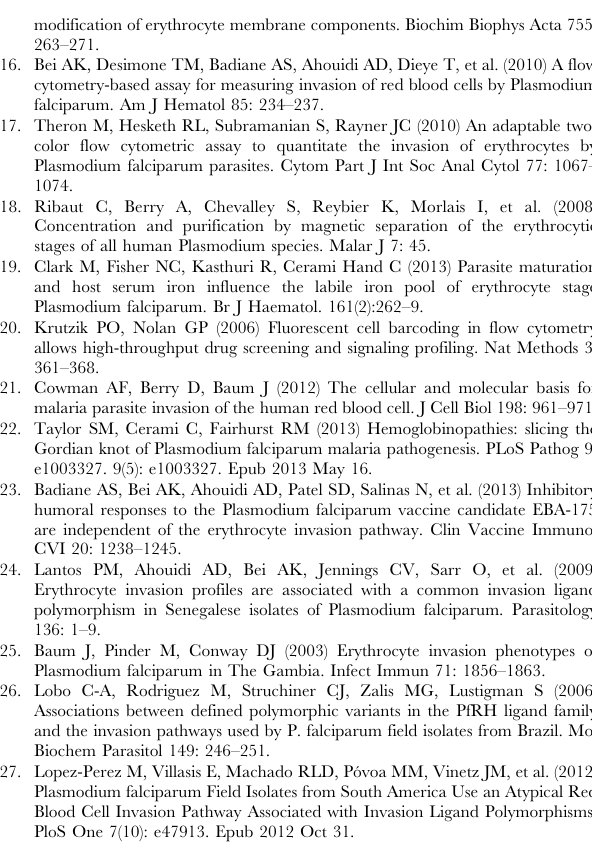
Figure S1 Barcoding RBCs with CellTrace Violet does not impact P. falciparum invasion. An equal number of RBC Violet and RBC unlabeled (1 6 10 7 ) were combined for a total of 2 6 10 7 uninfected RBCs per well, and inoculated with 2 6 10 5 MACS purified trophozoite stage P. falciparum strains 3D7, Dd2 or FCR3-FMG. Invasion experiments were incubated 18–24 hours to allow for rupture of schizonts and subsequent invasion of merozoites into labeled RBCs, then stained with DNA dye SYBR Green I (to identify pRBCs), fixed and analyzed by flow cytometry. The SI, an unadjusted odds ratio assessing the relative risk of RBC Violet and RBC unlabeled to 3D7 and Dd2 invasion, was determined. The marker represents the SI point estimate and the bar represents the 95% confidence interval (CI). Data is from a representative experiment of three independent experiments, each performed in triplicate. (TIF) Figure S2 Effect of replacing CellTrace Violet barcoded RBCs with DDAO barcoded RBCs on P. falciparum strain 3D7 and Dd2 invasion. RBCs were labeled with either CellTrace DDAO or Violet and 1.8 6 10 7 , 1 6 10 7 , and 2 6 10 6 Violet labeled RBCs (RBC Violet ) were combined with 2 6 10 6 , 1 6 10 7 , and 1.8 6 10 7 of DDAO labeled RBCs (RBC DDAO ) to achieve 10:1, 1:1, and 1:10 combinations of RBC Violet to RBC DDAO in the barcoded RBC invasion assay. Invasion assays were inoculated with 2 6 10 5 of MACS purified trophozoite stage P. falciparum strain 3D7 or Dd2 parasites and invasion assays were performed as previously described. Data is from a single representative experiment of three independent experiments